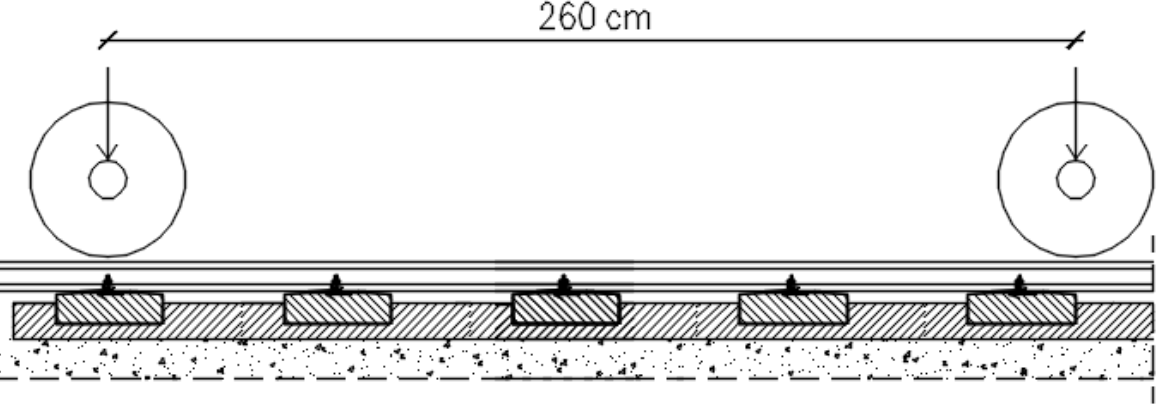
Figure 11. Scheme of loading the railway surface with a locomotive.